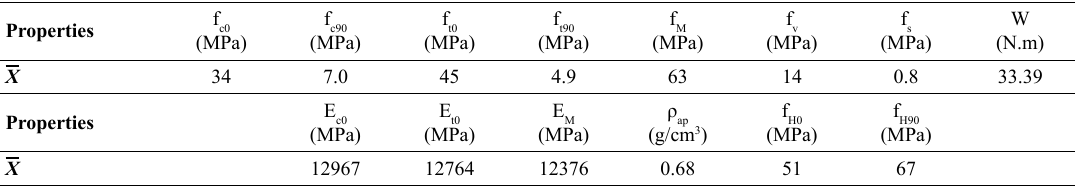
Table 5. Mean values of the literatuwre for the strength and fracture toughness properties of Erisma uncinatum Warm (Cambará). Properties